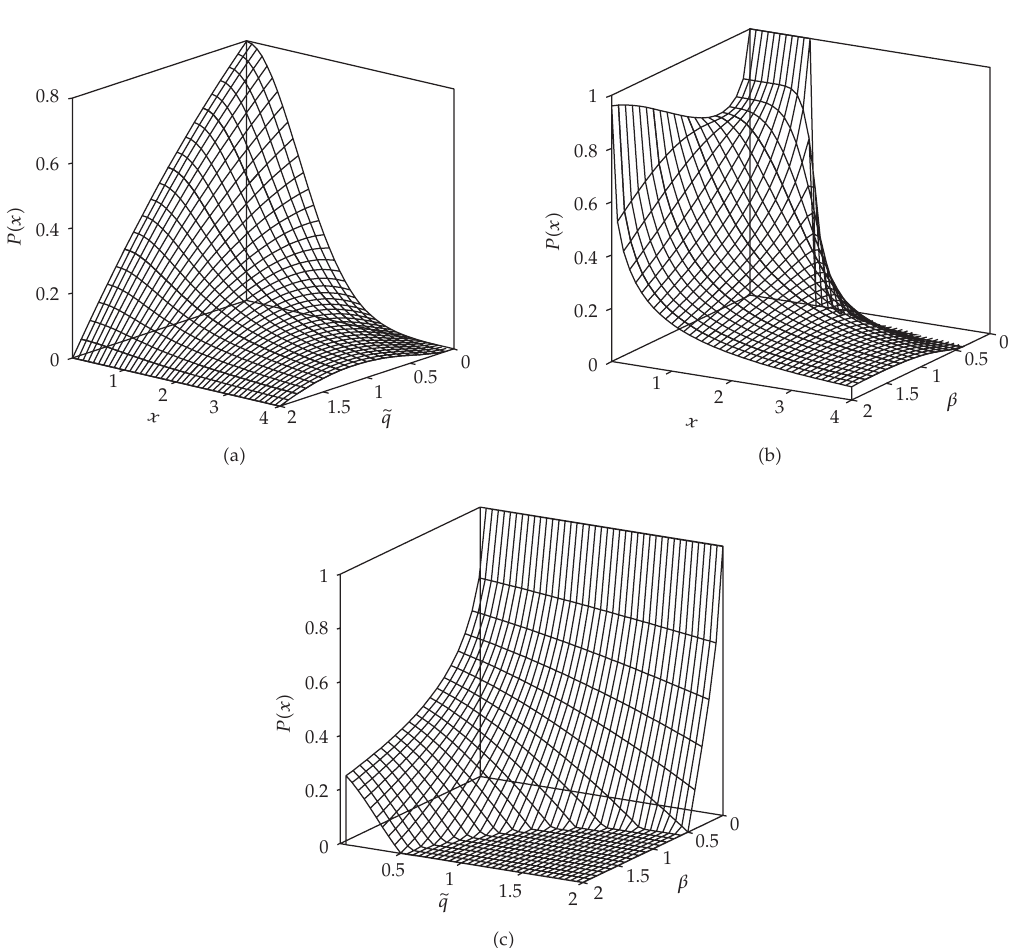
Figure 1: Behavior of (cid:2) 5.3 (cid:3) as a function of (cid:2) a (cid:3) x and (cid:2) q , with β (cid:7) 1 / 2 and a (cid:7) 1, (cid:2) b (cid:3) x and β , with (cid:2) q (cid:7) 1 / 5 and a (cid:7) 1, (cid:2) c (cid:3) (cid:2) q and β , with x (cid:7) 1 and a (cid:7) 1.